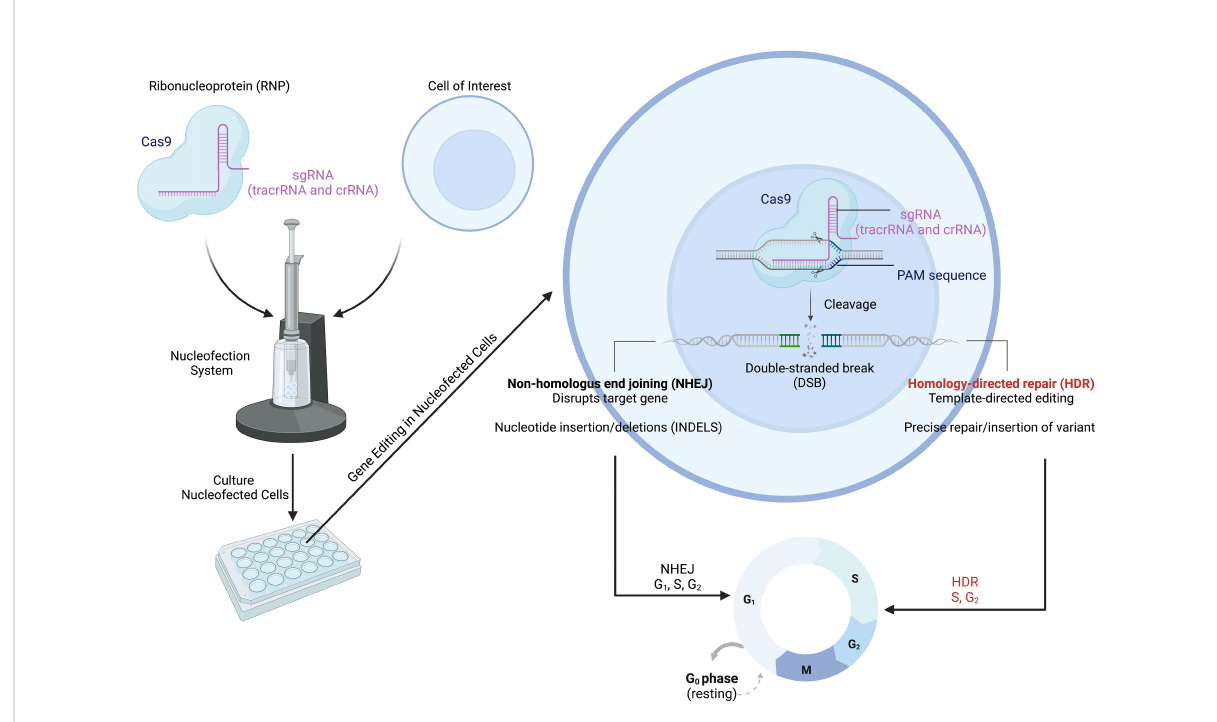
FIGURE 3 CRISPR-Cas9 gene editing to model IEIs/PIRDs. The CRISPR-Cas9 system consists of the Cas9 protein in complex with a targeting gRNA, forming a ribonucleoprotein (RNP). Speci fi city is conferred through various mechanisms including the sgRNA and presence of the PAM sequence. The Cas9 opens and cuts the targeted sequence on both strands to generate double-strand breaks (DSBs). This activates DNA repair pathways (NHEJ and HDR) in cells and results in modi fi cations at a target locus. The NHEJ pathway can be used for scenarios in which genetic variants result in the loss of expression of an encoded protein, while HDR can be employed for introduction of missense mutations. IEIs, inborn errors of immunity; PIRDs, primary immune regulatory disorders; sgRNA, single-guide RNA; PAM, protospacer adjacent motif; NHEJ, non- homologous end joining; HDR, homology-directed repair. Adapted from “ CRISPR/Cas9 Gene Editing ” , by BioRender.com (2022). Retrieved from